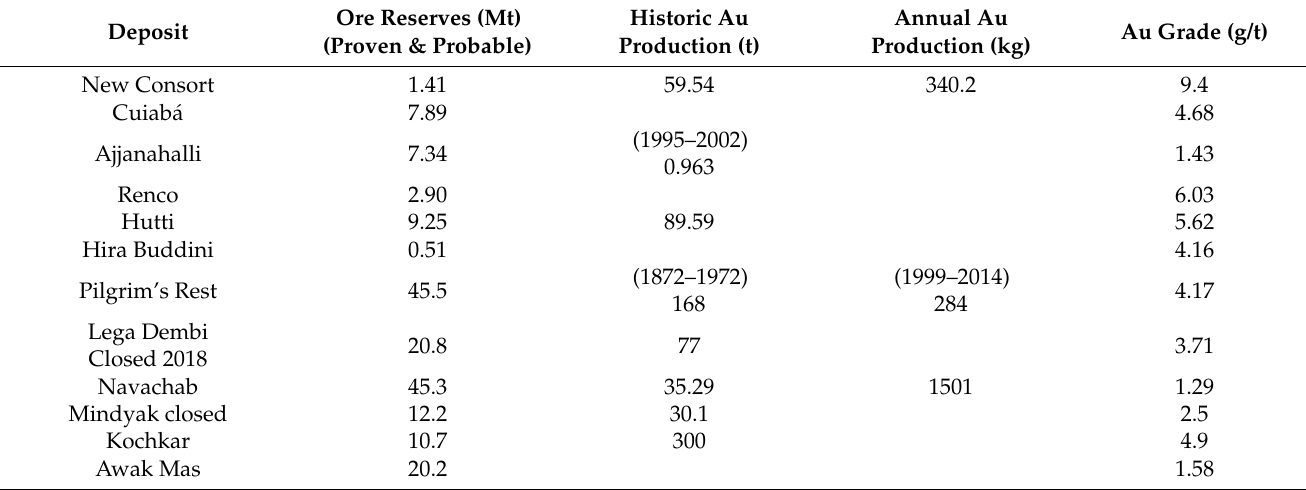
Table 8. Gold reserve, production, and